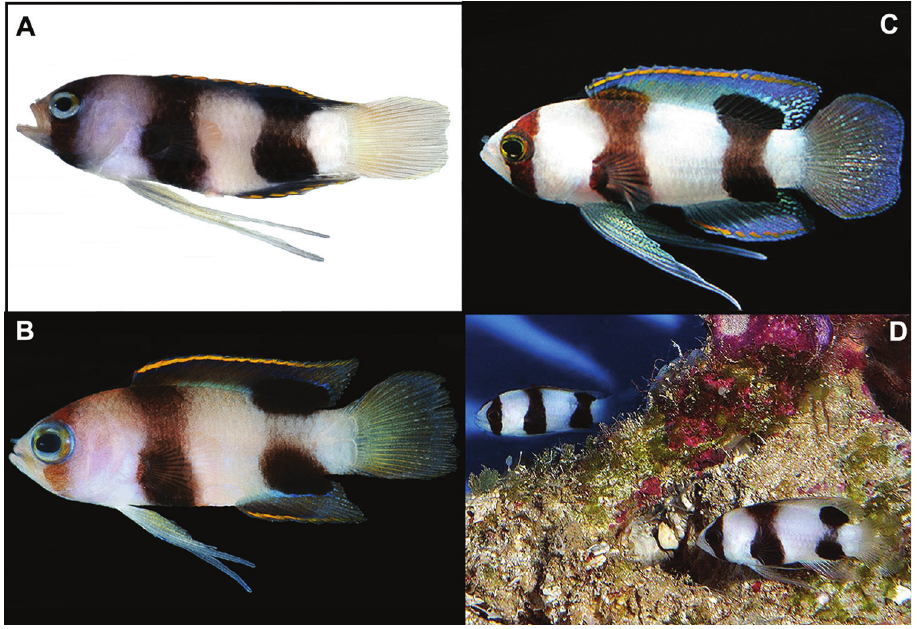
Figure 2. Lipogramma levinsoni sp. n. A USNM 406139, holotype, 28.3 mm SL, photographed prior to preservation, photo by D. R. Robertson and C. C. Baldwin B USNM 406394, 22.2 mm SL , photo- graphed prior to preservation, photo by D. R. Robertson and C. C. Baldwin C and D Aquarium photos, Curaçao Sea Aquarium, photos by D. Ross